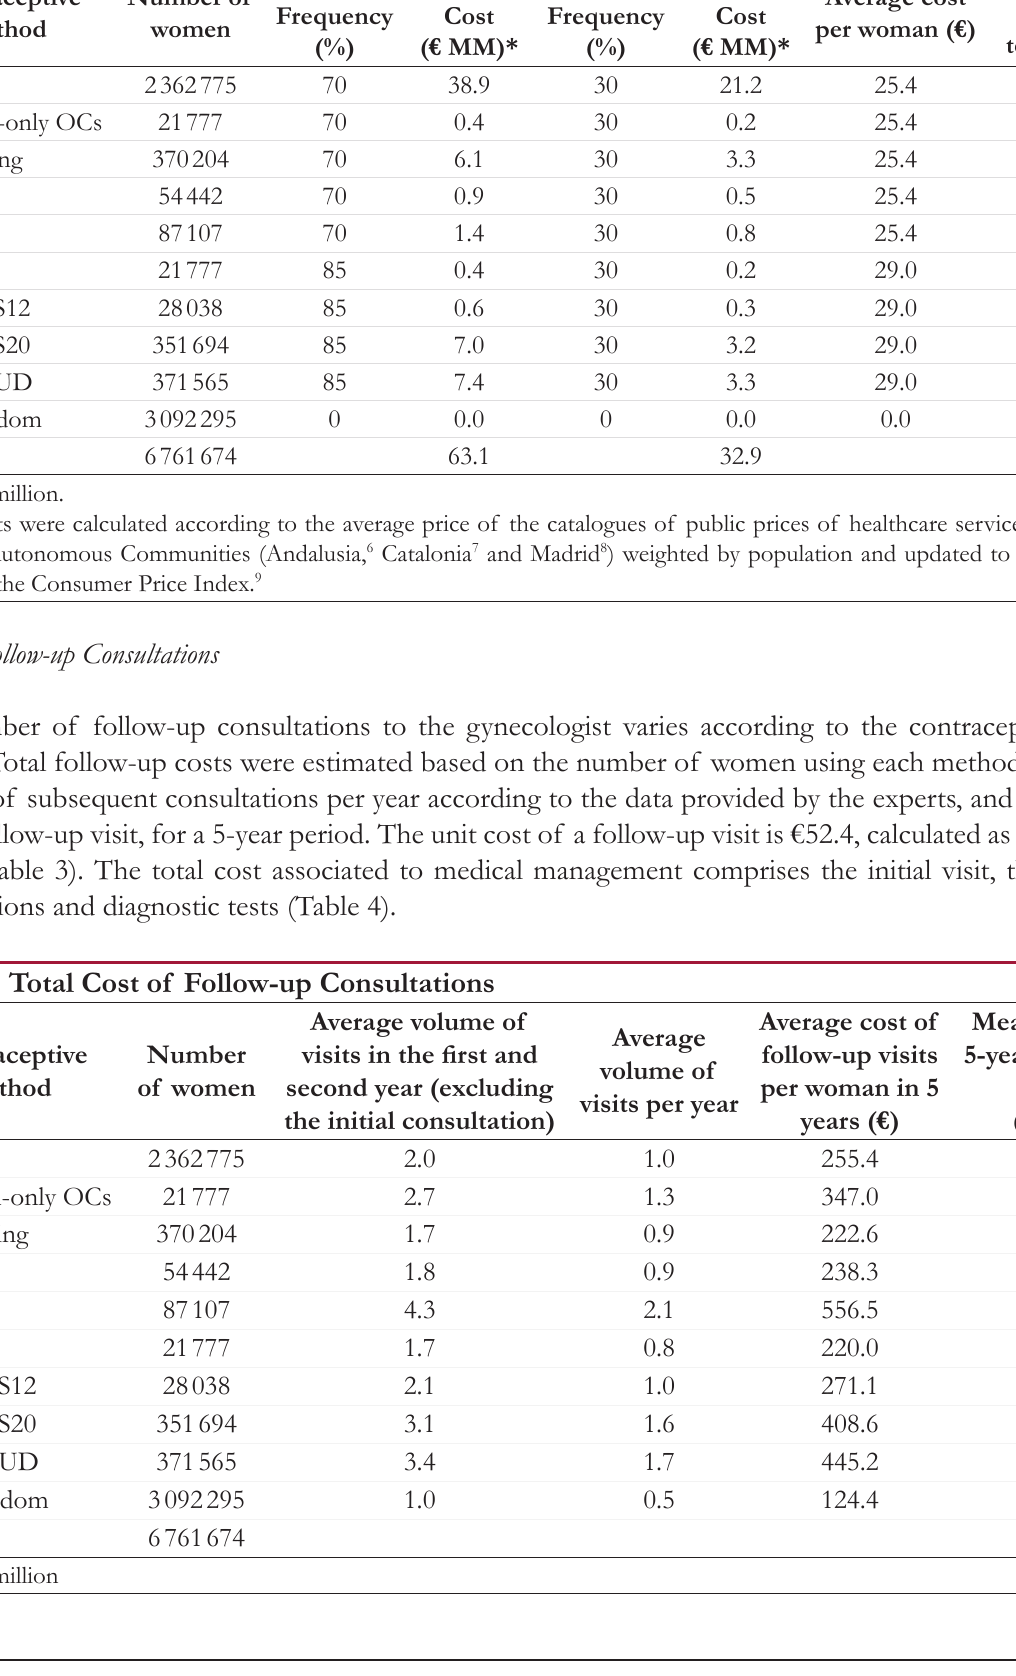
Table 2. Total Cost of Diagnostic Tests to Initiate Contraceptive Therapy Contraceptive